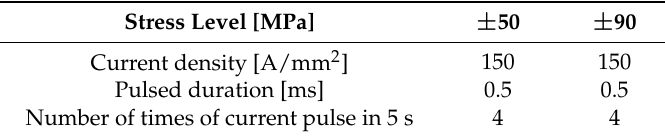
Table 2. EPT conditions applied in fatigued specimens.